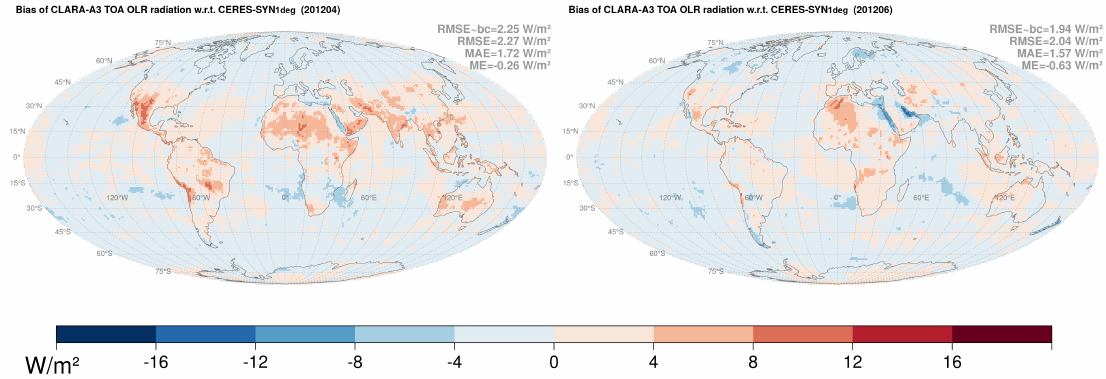
Figure 9. Monthly mean OLR difference with respect to CERES SYN1deg for April 2012 ( left ) and June ( right ) based on METOP-A and NOAA-19 (i.e., two